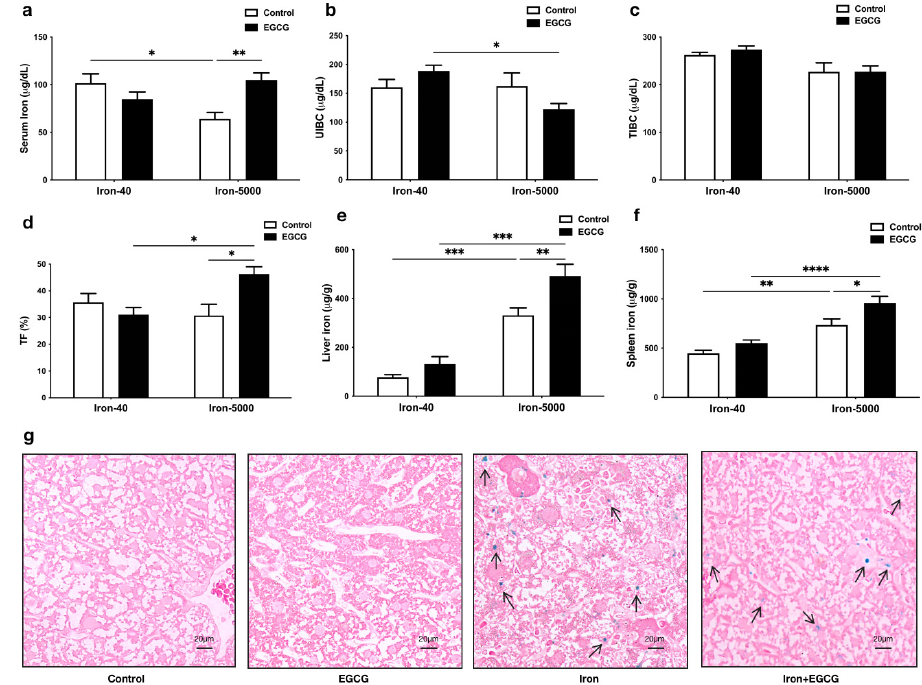
Figure 3. EGCG appears to contribute to the maintenance of iron homeostasis in mice fed an iron-rich diet. ( a – d ) Serum iron, UIBC, TIBC, and TF were tested in all groups of mice. ( e , f ) Iron content of the liver and spleen ( n = 10). ( g ) The Perls stained sections of mouse liver tissues ( n = 5). The arrows point to the iron stained in Perls in the liver. Scale bar, 20 µ m. The results of the two-way ANOVA are denoted by p -values, p < 0.05 (*), p < 0.01 (**), p < 0.001 (***), p < 0.0001 (****).